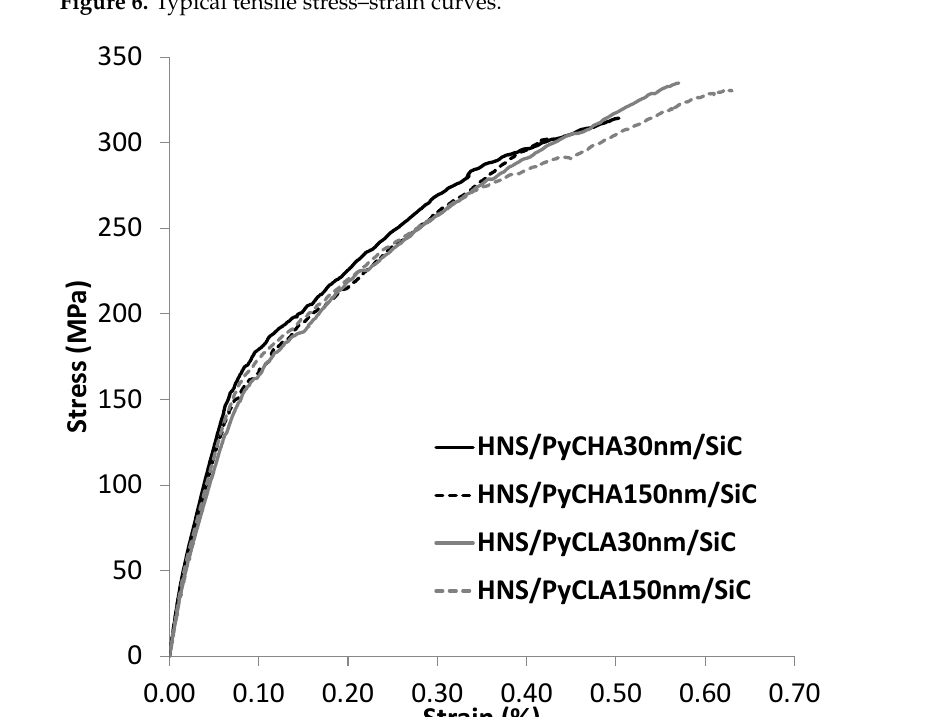
Figure 6. Typical tensile stress–strain curves.